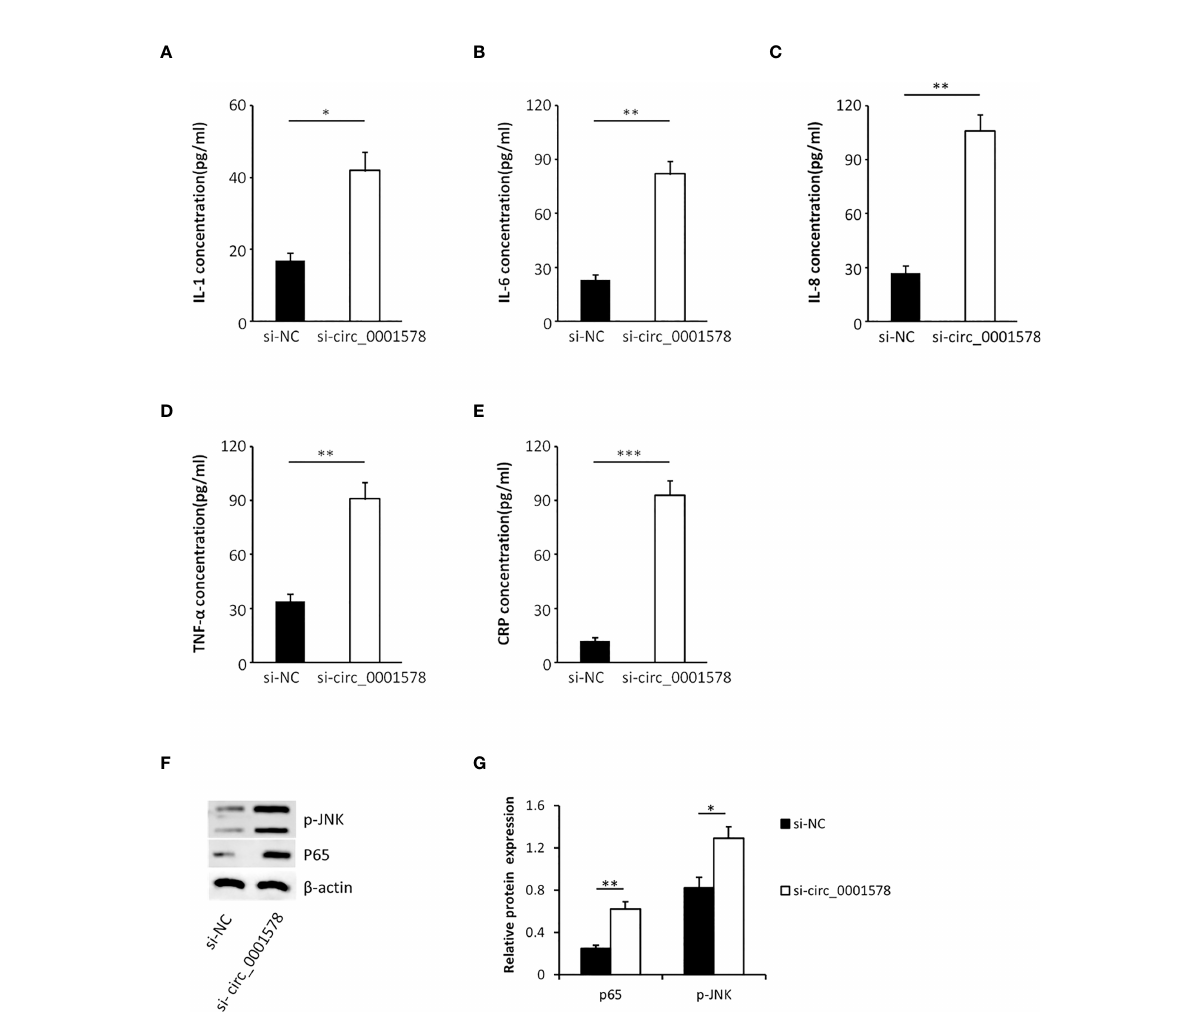
FIGURE 4 Downregulation of circ_0001578 induces in fl ammation in trophoblasts. (A) IL-1 levels were signi fi cantly higher in the culture medium treated with si-circRNA than in the si-NC group (P < 0.05). (B) IL-6 levels were signi fi cantly high in the culture medium treated with si-circRNA than in the si-NC group (P < 0.01). (C) IL-8 levels were signi fi cantly higher in the culture medium treated with si-circRNA than in the si-NC group (P < 0.01). (D) TNF- a levels were signi fi cantly higher in the culture medium treated with si-circRNA than in the si-NC group (P < 0.01). (E) CRP levels were signi fi cantly higher in the culture medium treated with si-circRNA than in the si-NC group (P < 0.001). (F) Expression levels of p-JNK and nuclear P65 followed by circ_0001578 knockdown detected by Western blotting. (G) Semiquantitative analysis of protein expression *P<0.05; **P<0.01;